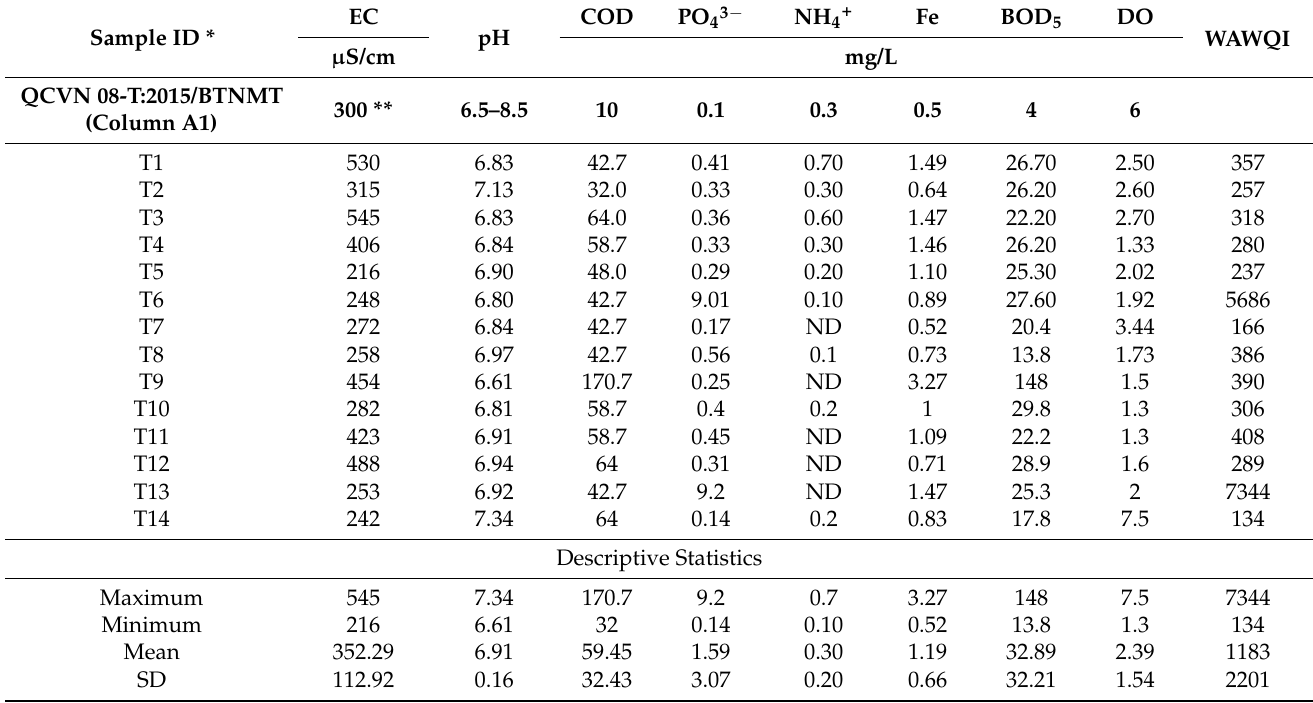
Table 6. Calculation of WAWQI for the MXAC in the 2016 Dry Season.